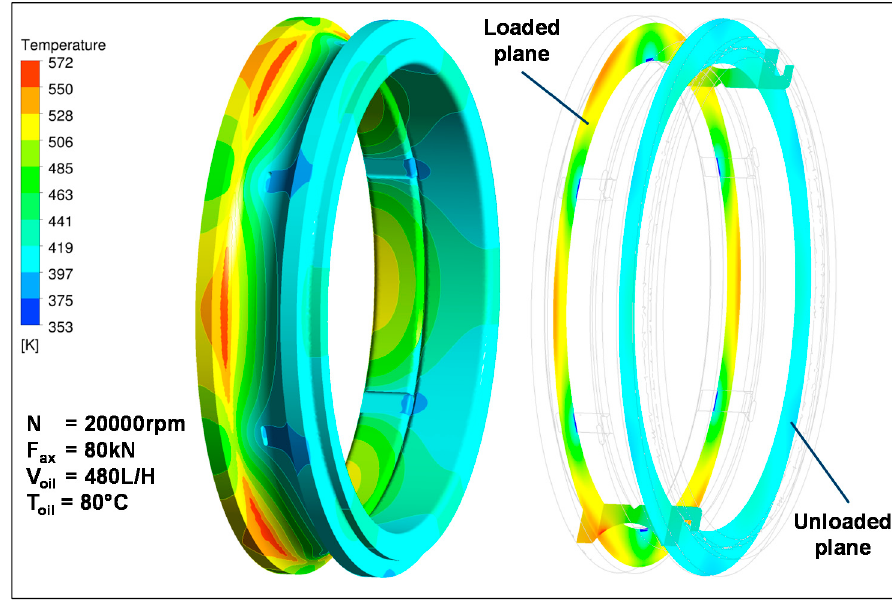
Figure 15. ( a ) The Outer ring of the bearing. On the LHS, the oil inlet and outlet of the outer ring cooling duct and the position of the heat flux into the material by the rolling elements are shown. On the RHS the inlet and outlet are shown and also the interface to the SQF; ( b ) A perpendicular cut through the mesh (Outer ring, Fluid and Hub).